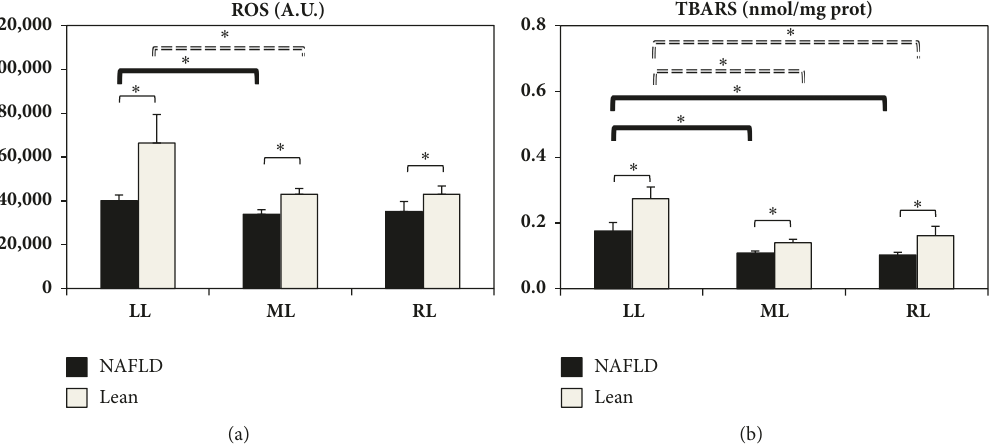
Figure 7: Hepatic levels of ROS (a) and TBARS (b) obtained from LL, ML and RL in NAFLD and Lean rats. Data are shown as mean values ± SE. ∗ p <